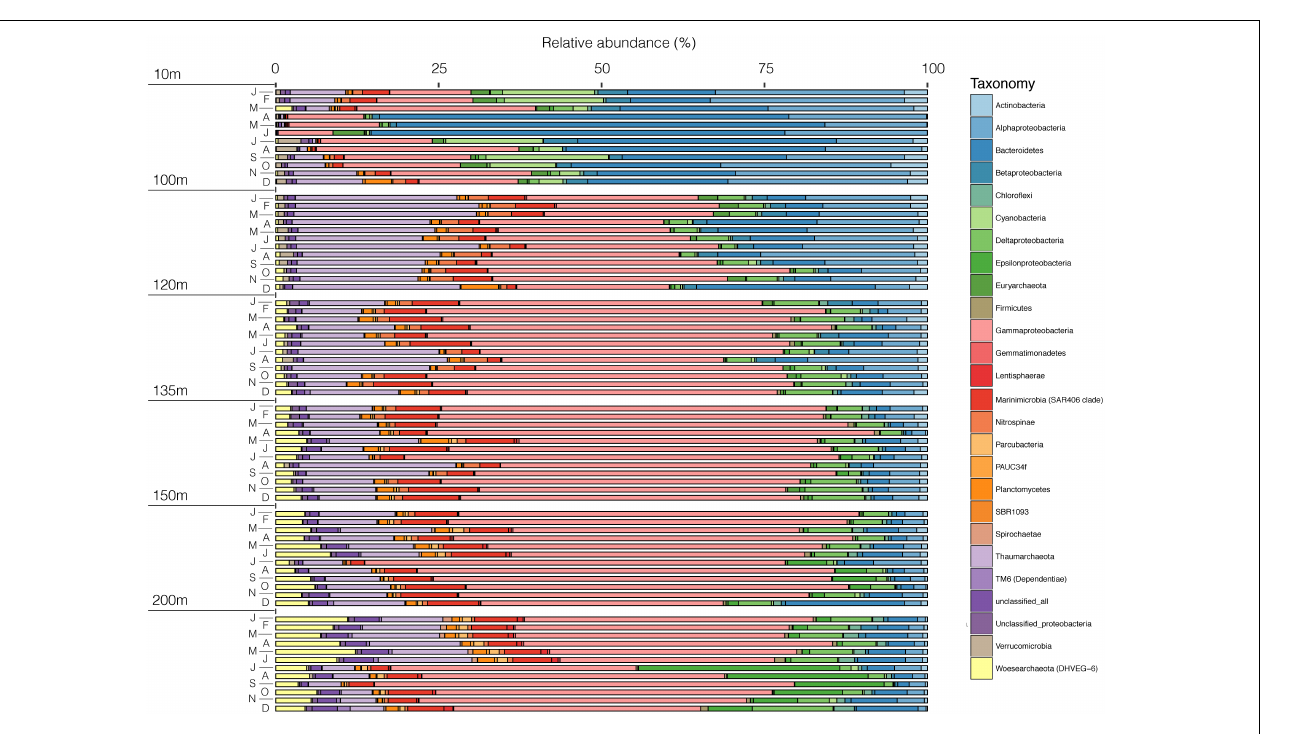
FIGURE 7 | Microbial community composition of SI in 2015 for 6 depths (10, 100, 120, 135, 150, and 200 m) at the phylum level in relative